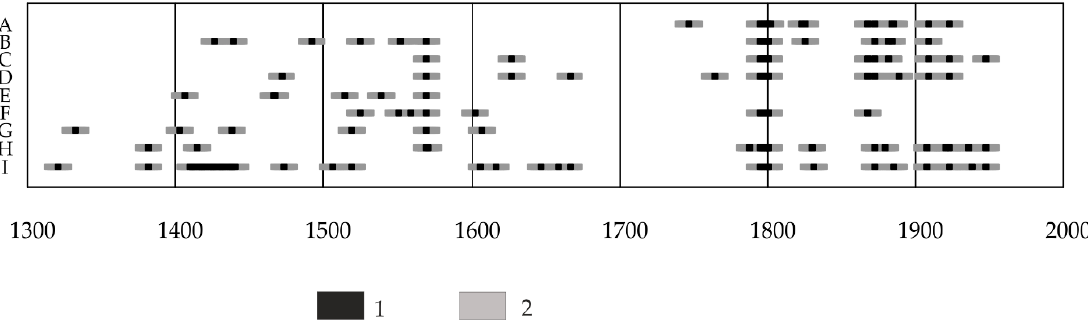
Figure 2. Operation of water mills in the Struga Rychnowska catchment. Notation: periods of watermill operation: 1—confirmed, 2—conjectured; ponds A–I: as in Figure 1.